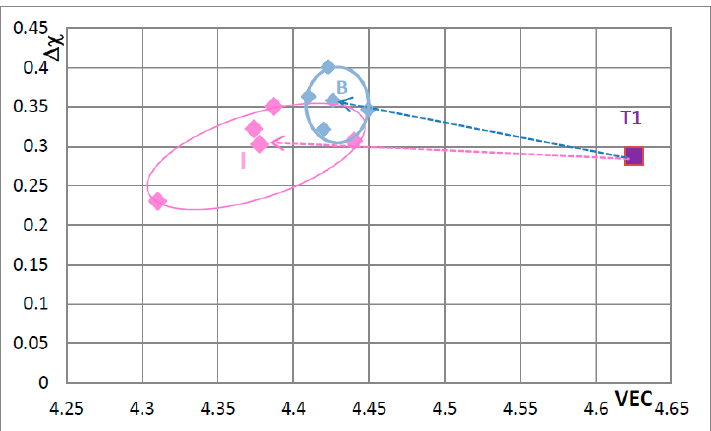
Figure 11. Δχ versus VEC map of unalloyed and alloyed Nb 5 Si 3 to show the “direction of change” of the position of the silicide in the map with alloying. T1 is Nb 5 Si 3 and the areas B and I have data for (Nb,Ti,Cr) 5 (Si,Al) 3 and (Nb,Ti,Cr) 5 (Si,Al,Ge,Sn) 3 , respectively. The data is from KZ5 type alloys with nominal compositions Nb-24Ti-18Si-5Al-5Cr + X, where X = 5Ge + 5Sn. Average positions in areas B and F to H are indicated by data point closest to letter (see text). For arrows see text.